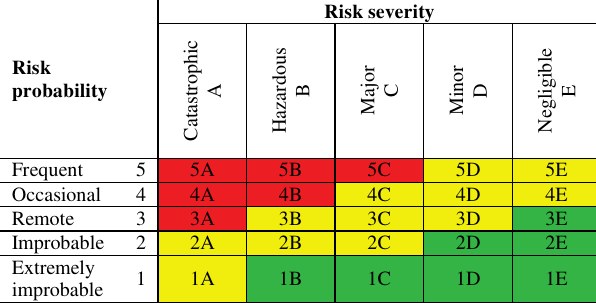
Table 3. Safety risk assessment matrix [13]